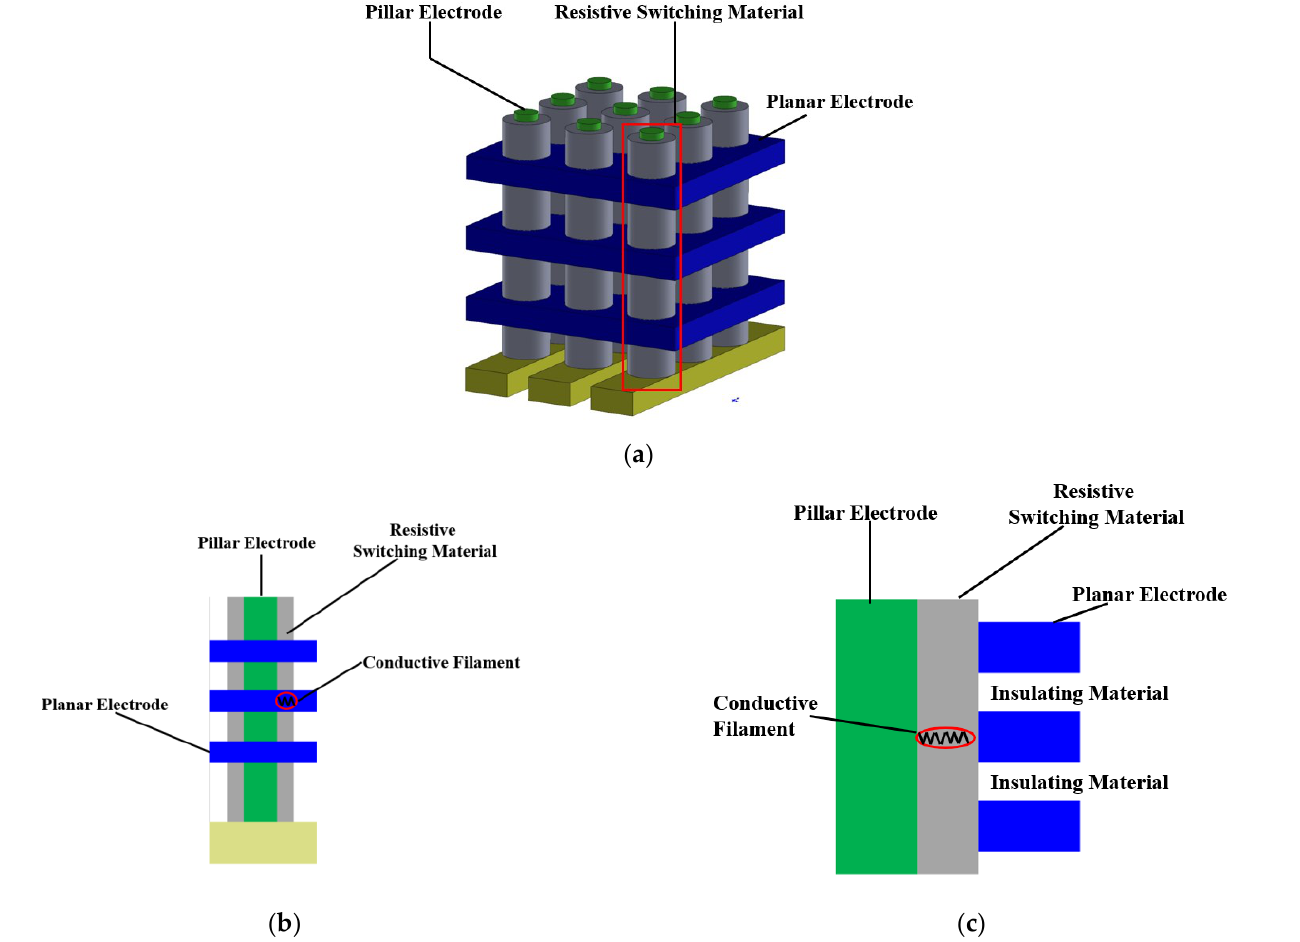
Figure 2. ( a ) Schematic of Pt-RRAM array, ( b ) details of Pt-RRAM cells in one pillar electrode, and ( c ) cross section of Pt-RRAM cells through the central axis of the pillar electrode.